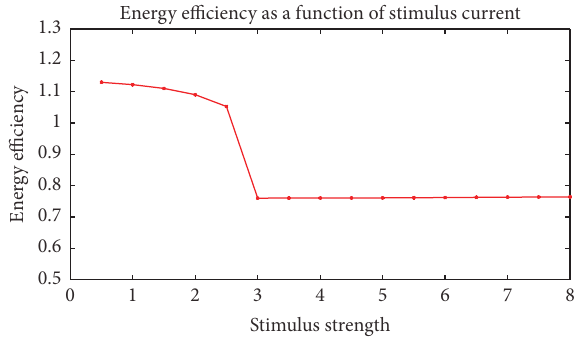
Figure 18: Energy efficiency as function of stimulus current stren- gth.